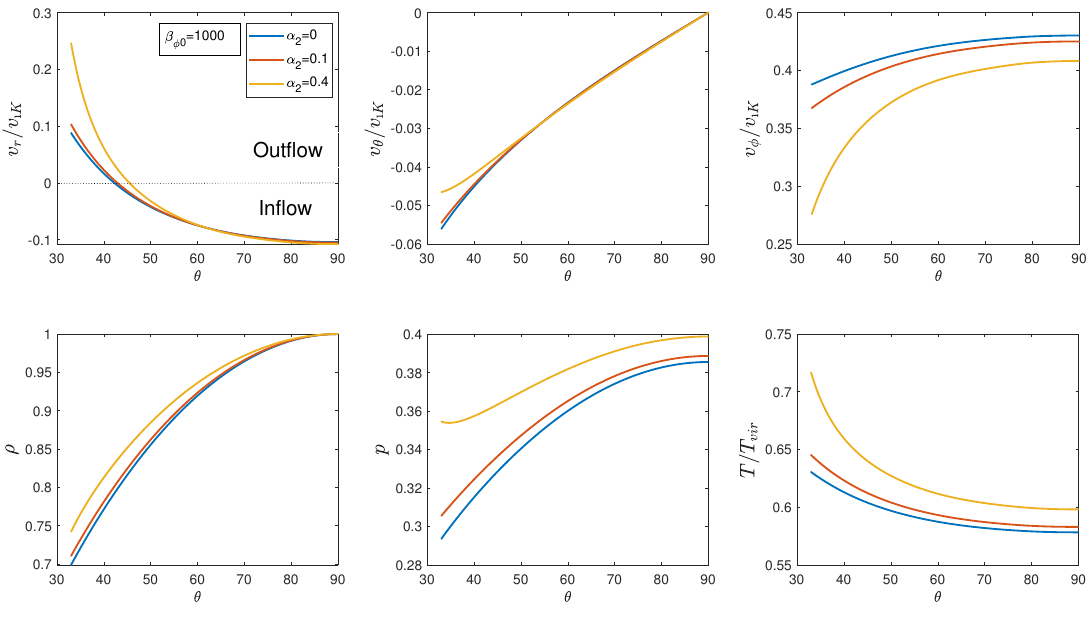
Figure 1. Angular profiles of velocities ( v r , v θ , v φ / v k ), density ( ρ ), pressure ( p ), and temperature ( T / T vir ). The blue, red, yellow lines correspond to parameters α 2 = 0.0,0.1,0.4, respectively. In this model, we set the gas pressure is 1000 times larger than the magnetic pressure at the